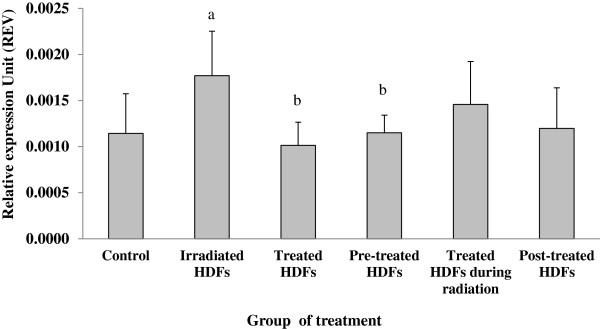
Relative expression value of p16ink4a gene in different treatment groups of HDFs. aDenotes p < 0.05 compared to untreated control, bp < 0.05 compared to irradiated HDFs. Data are expressed as mean ± SD (n = 6).